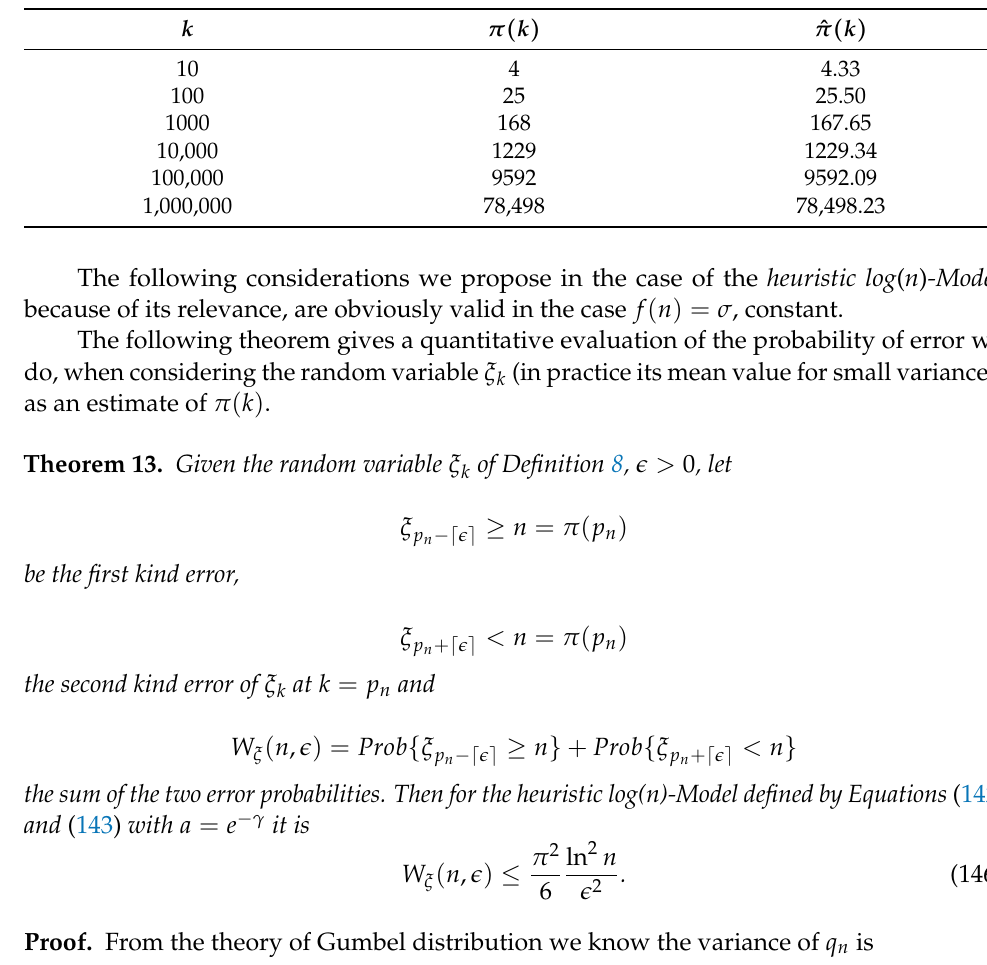
Table 5. π ( k ) estimate through heuristic log ( n ) -Model